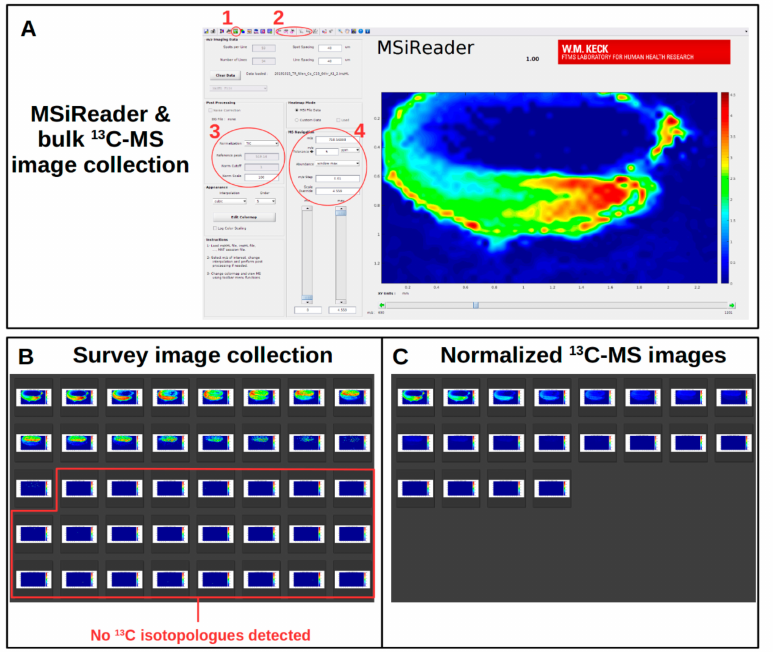
Figure 3. MSiReader software to analyze 13 C-MSI data and photo gallery software to view collected images. ( A ) MSiReader is able to collect images using its “bulk processing” feature (1) and abundance values with “MSi Export” (2). Important settings include normalization (3) and the m/z and “m/z Tolerance” (4). The image depicted in the viewing window is [ 13 C0] PC 34:2 from a Camelina embryo (embryonic axis on the bottom, red and green; cotyledons on the top, dark blue). ( B ) A survey image collection is first done to determine the extent of 13 C-labeling and the isotopologue with the greatest abundance. ( C ) Normalized 13 C-MS images are collected by discarding the m/z values without signal (as determined from the survey collection) and by locking the intensity